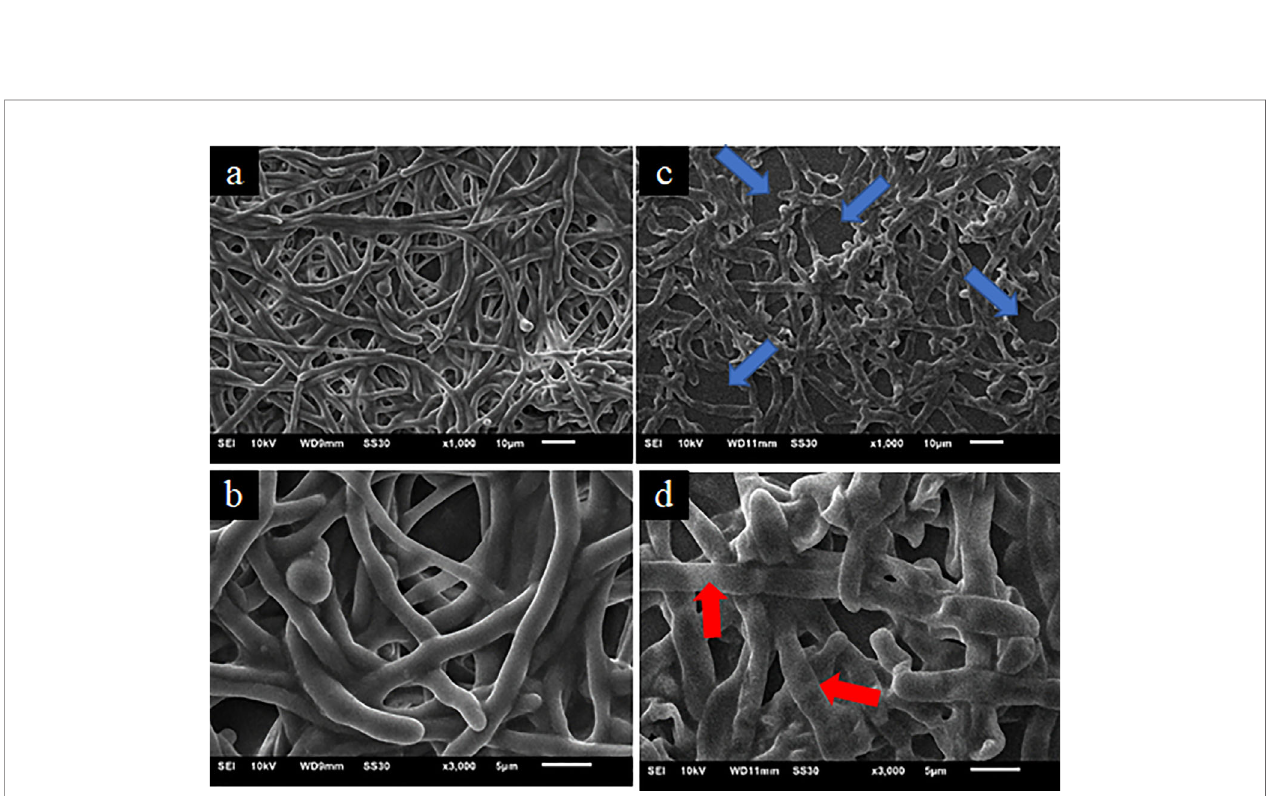
FIGURE 6 | Scanning electron microscopy images of mature T. rubrum ATCC 28189 bio fi lms treated with 2-chalcone combined with blue LED at a dose of 150 J/cm 2 (C, D) and irradiated only at a dose of 150 J/cm 2 without the photosensitizer (A, B) . The blue arrows indicate empty spaces within the bio fi lm showing that the bio fi lm had become less dense. The red arrows show collapsed